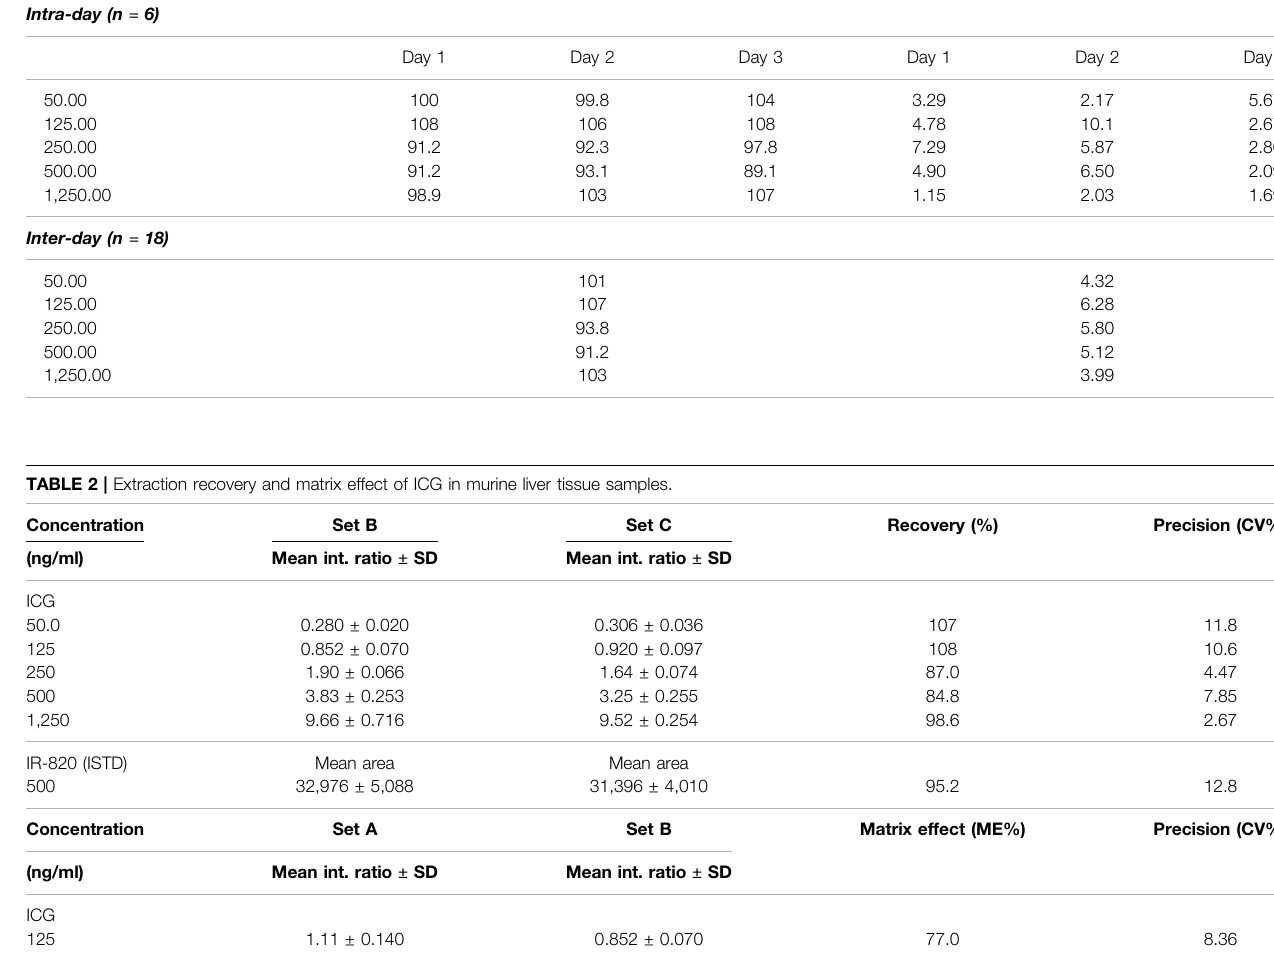
ratio values of ICG QC samples extracted (Set B) were compared